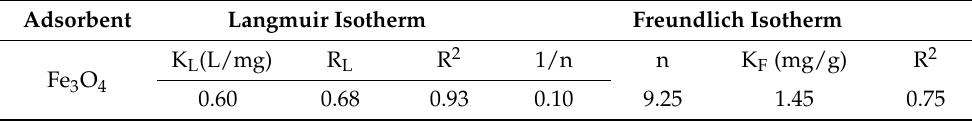
Figure 9. Freundlich model for the adsorption of lead ions from wastewater. Table 2. Adsorption isotherm